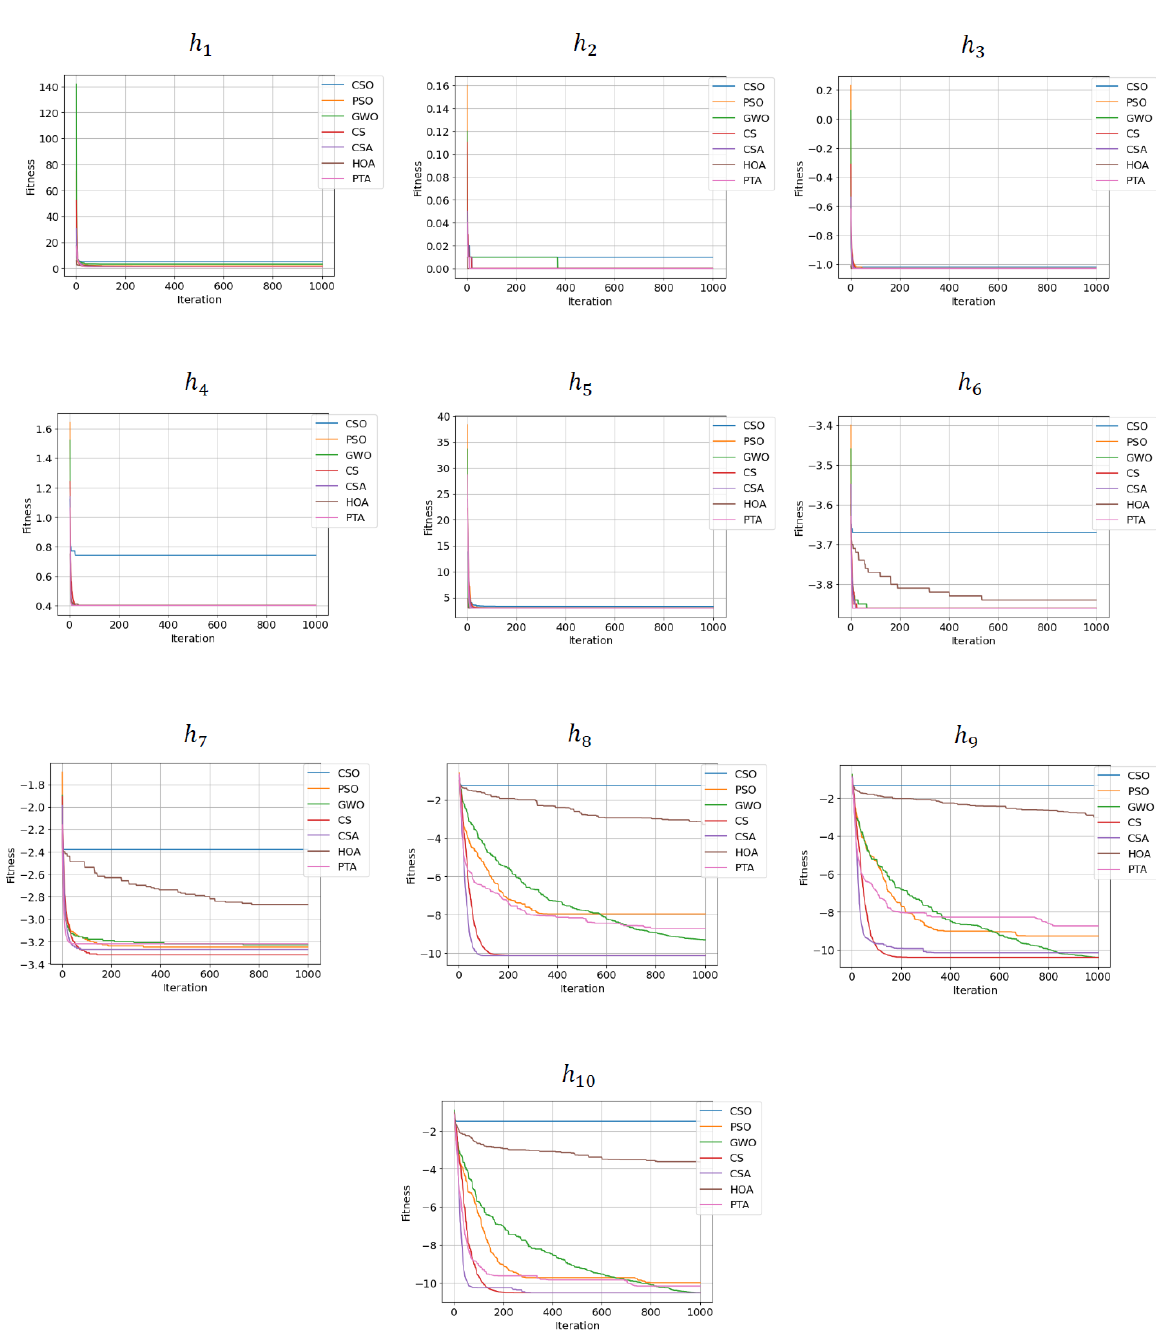
Figure 7. Convergence Charts for the Objective Functions ℎ 1 − ℎ 10 .